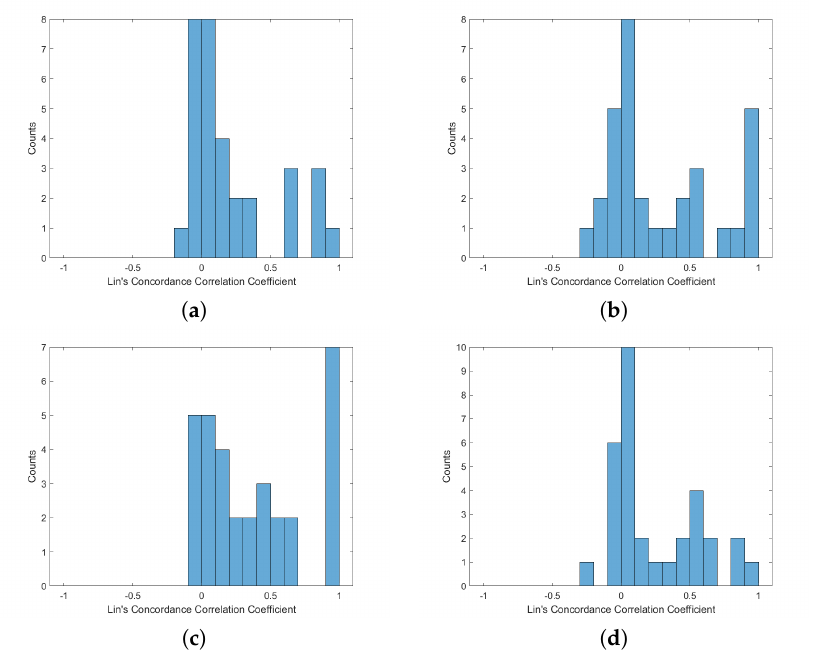
Figure A5. Histogram of Lin’s Concordance Correlation Coefficient from ECG-HRV and BCG-HRV,